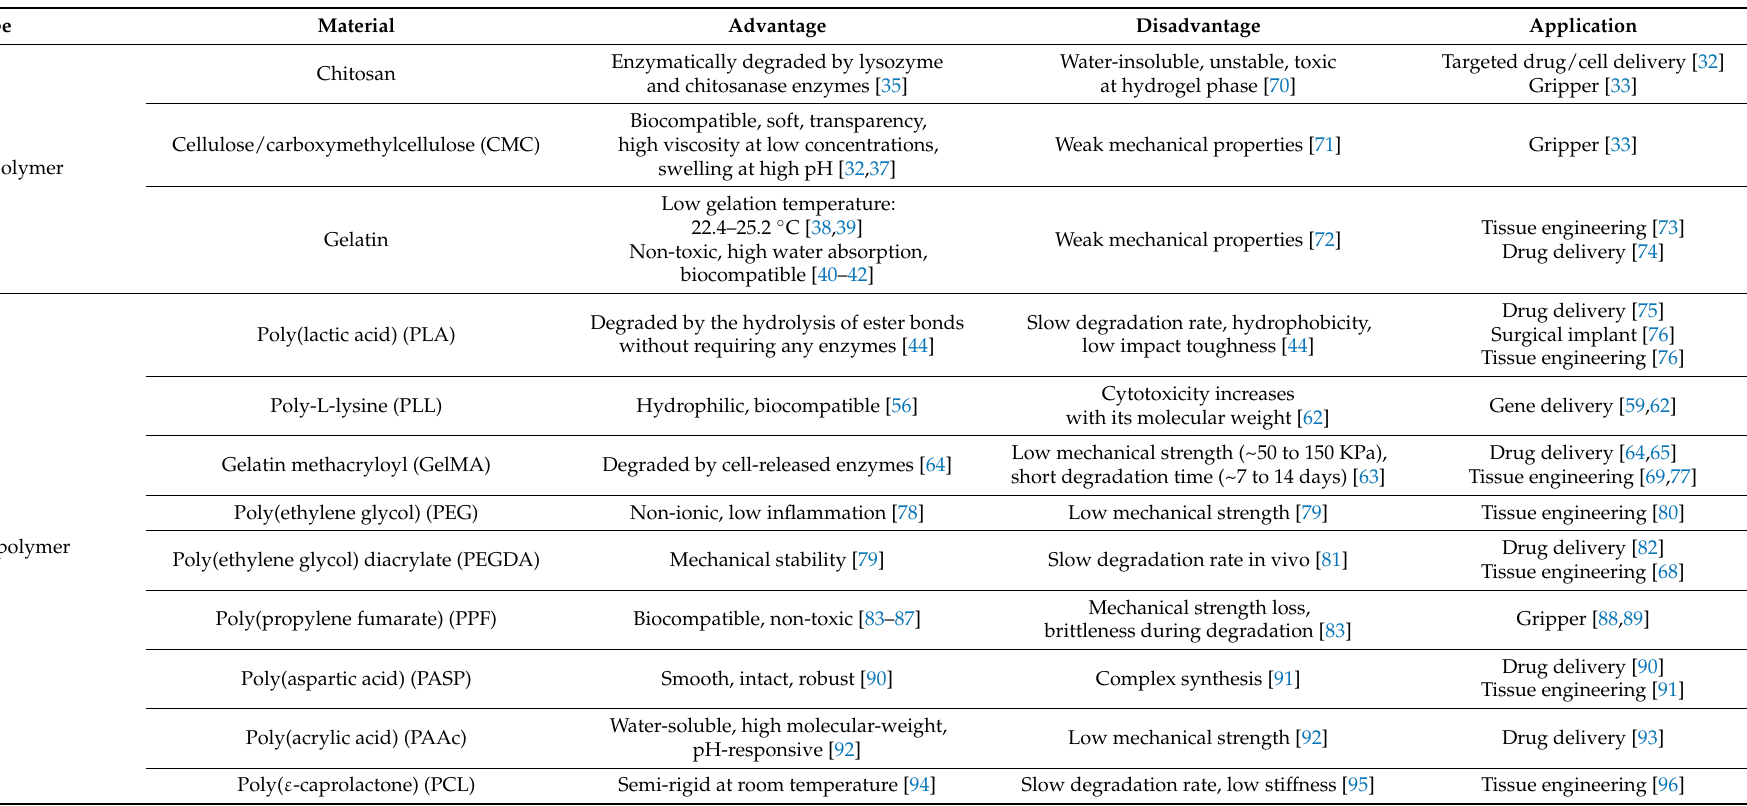
Table 1. Pros and cons of biodegradable materials and their